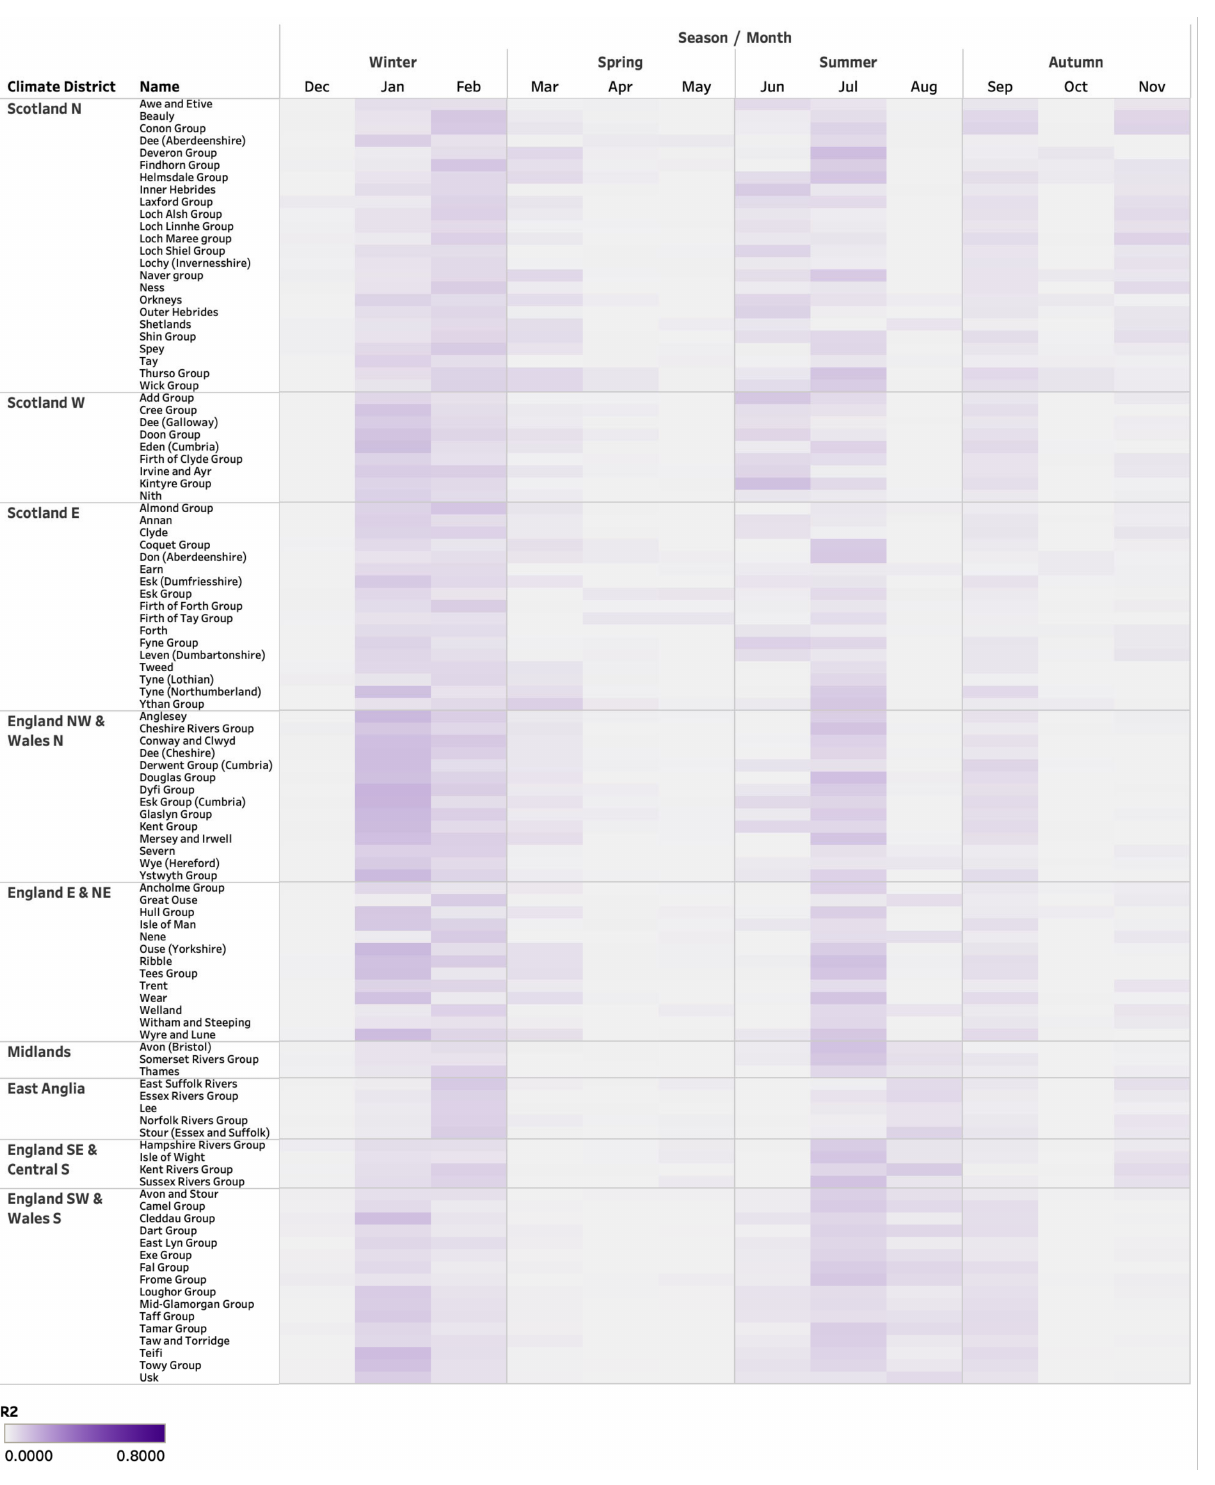
Figure A3. R 2 values of the univariate regression model exploring the relationship between the POL index and SPI-1 values across the IHU